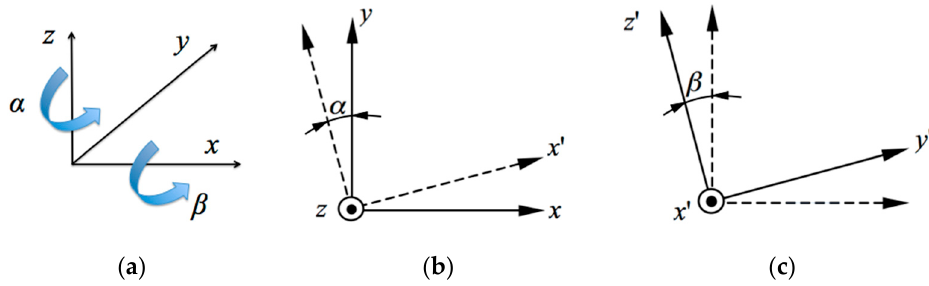
Figure 3. Transformations of the basic coordinate system oxyz to the declined coordinates: ( a ) Rotation directions; ( b ) Rotation around the z -axis by the angle α ; ( c ) Rotation around the x ′ -axis by the angle β .